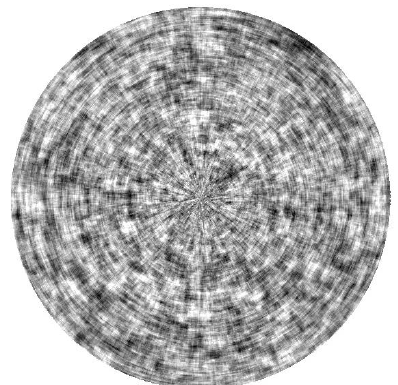
Figure 10. The images with uniform correlation Let’s c onsider the NCF view of circular image. The circular image in this model is actually a geometric transformation of a cylindrical one, so its NCF can be obtained from the NCF of a cylindrical image. Figure 11, a shows the values of NCF relative to the central pixel of this figure. It is natural that the isolines are circles. Figure 11, b shows the values of NCF and its isocorrelation lines relative to the pixel in the middle of a radius (maximum brightness). Isolines at short distances are close to rhombuses, as in Figure 6,